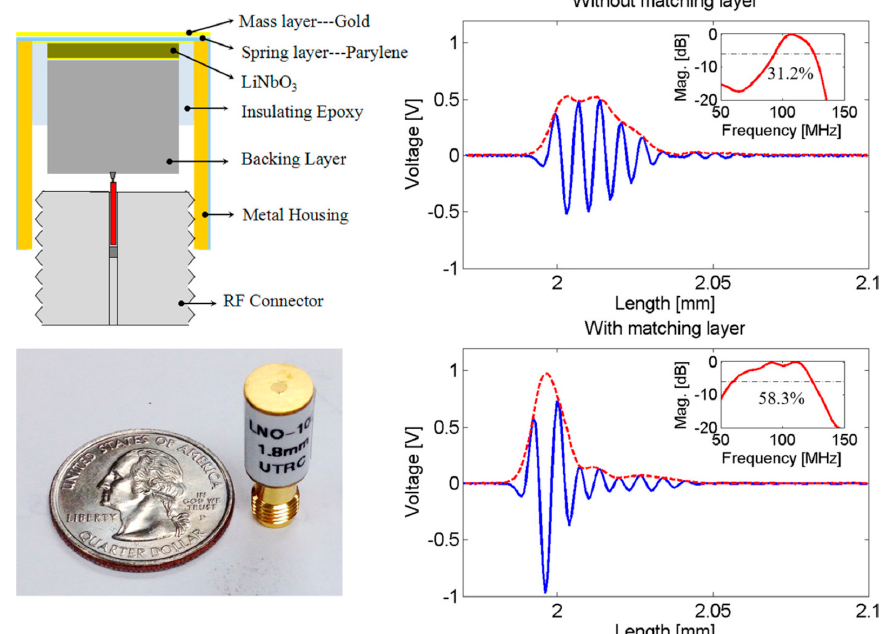
Figure 16. Schematic and photo of the 100 MHz LiNbO 3 transducer with matching layers shown on the left. A comparison is made on the right showing the pulse–echo experimental response of the transducer before and after the matching layers deposition on the top surface. Reprinted from [154], with the permission of AIP Publishing.